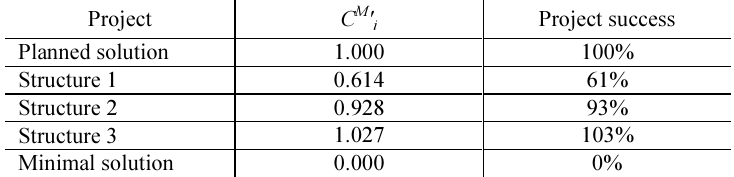
Table 9. Project